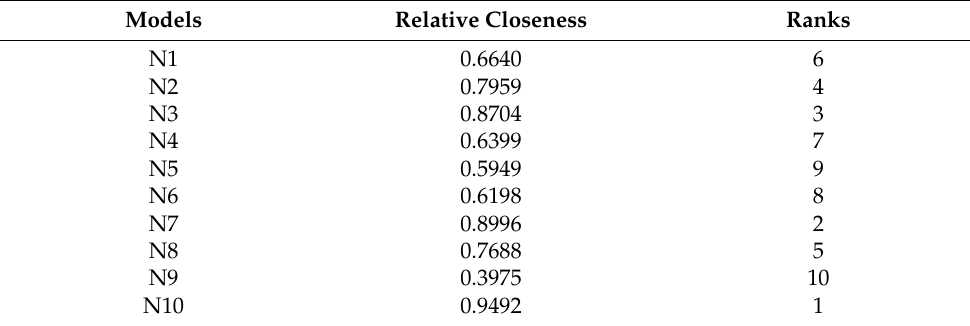
Table 11. Ranking normalization in Legendre network for Binance dataset.